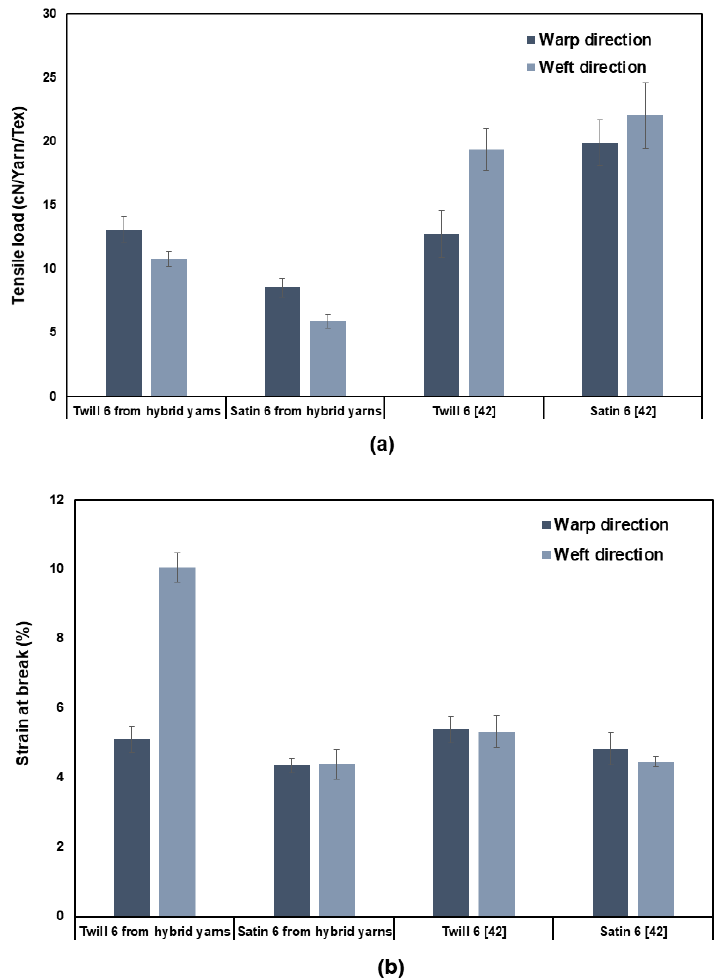
Figure 8. ( a ) The tensile load (in cN/yarn/Tex) of the woven fabrics; ( b ) the tensile strain at break of the woven fabrics.